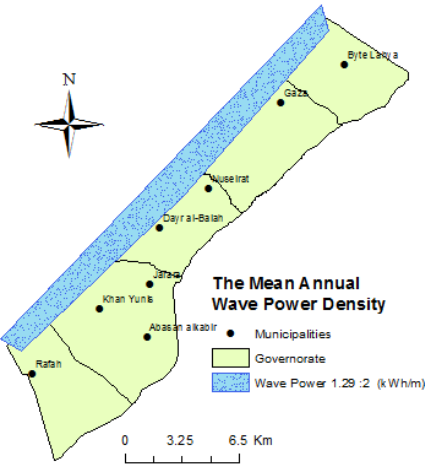
Figure 11. Distribution of total annual wave power density (kWh/m).